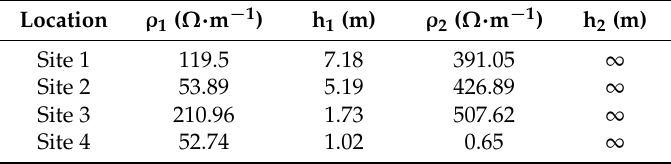
Table 1. Soil resistivity values for different